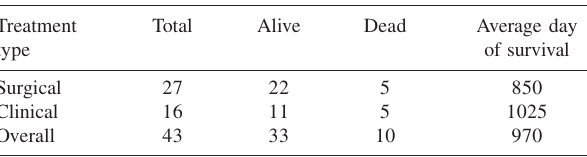
Table 6- Days of survival by type of treatment: surgical vs